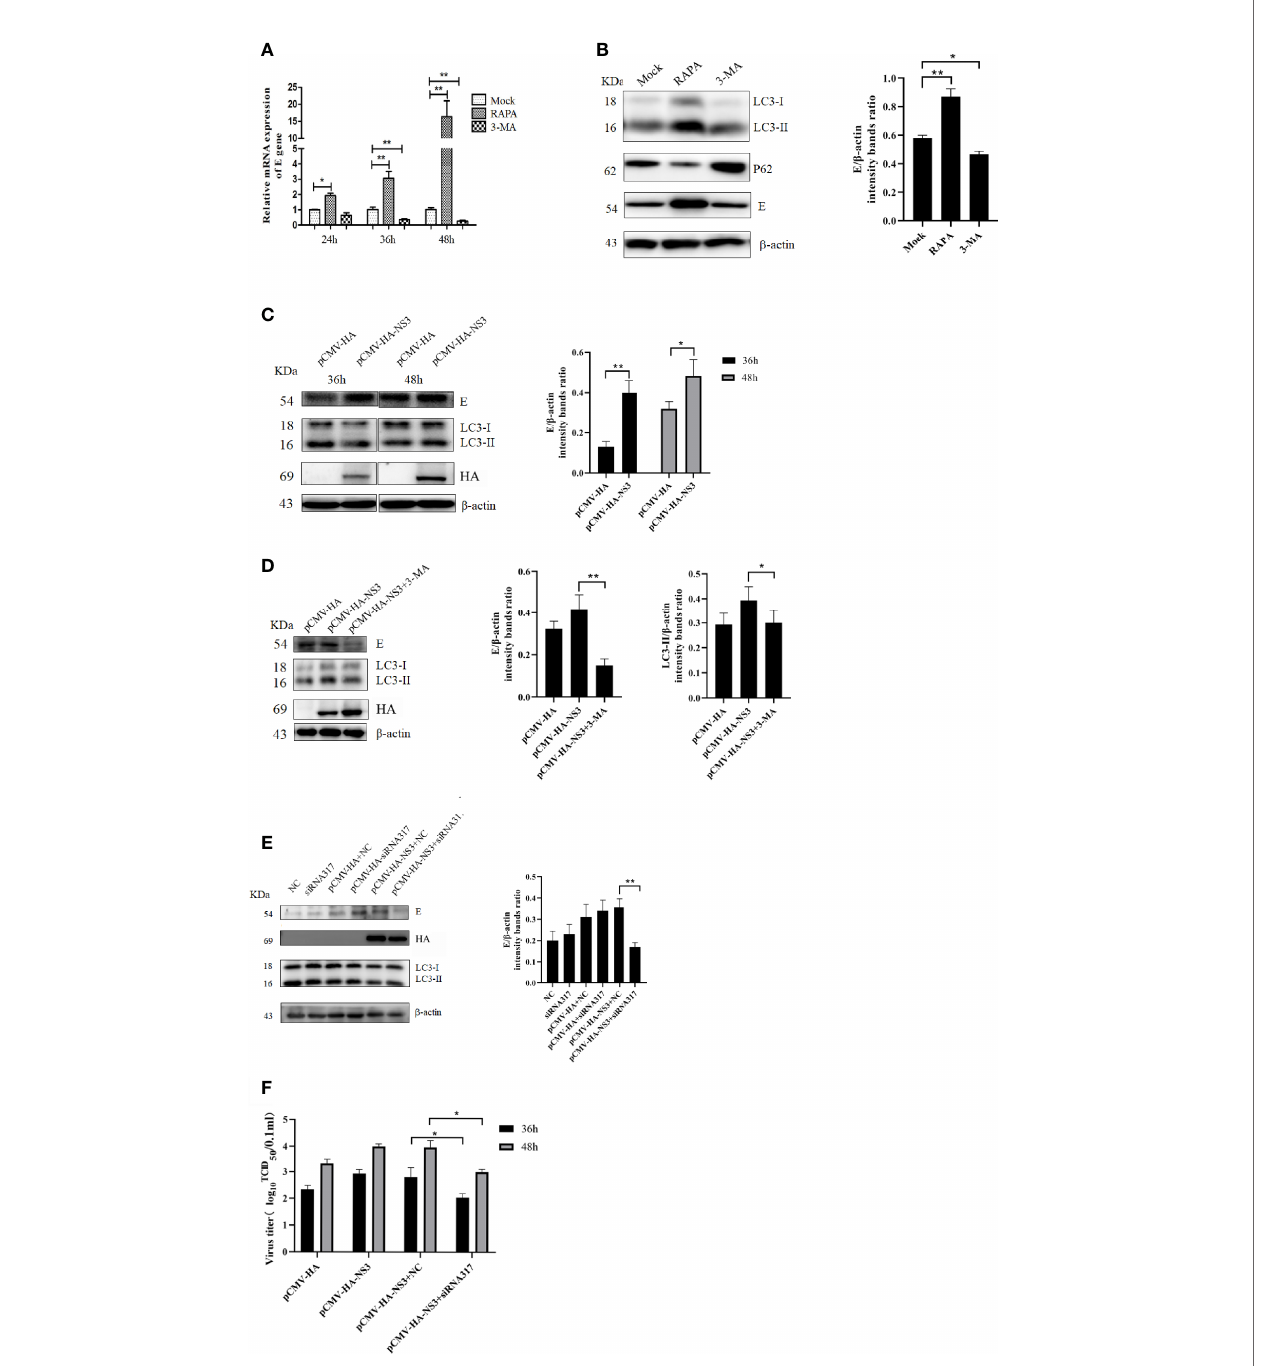
FIGURE 5 | Autophagy affects DTMUV ’ s replication. (A) DEF cells were treated with 3-MA (5 mM) or RAPA (5 m M) for 6 h to inhibit or induce autophagy, respectively, before being infected with DTMUV at an MOI of 0.3. Cell lysates were harvested at the indicated time for qPCR to test the relative expression of the E gene. (B) DEF cells infected with DTMUV for 36 h were lysed and analyzed by Western blot with anti-LC3, P62, and the E and b -actin antibodies. (C) BHK-21 cells were transfected with NS3 for 6 h and then infected with DTMUV (0.3 MOI), and the cell samples were collected at 36 and 48 hpi. (D) BHK-21 cells were treated with 3-MA (5 mM) for 6 h before being transfected with NS3 and subsequently infected with DTMUV. At 36 hpi, the E, LC3, and NS3 proteins were detected by Western blot. (E) DEF cells were transfected with NS3 for 6 h after being transfected siRNA for 24 h. The cells were infected with DTMUV (0.3 MOI), and the cell samples were collected at 36 hpi. (F) DEF cells were cultured in 6-well cell culture plates and infected with the virus (0.3 MOI) as described above. Cell supernatants were collected 36 and 48 h after infection, and virus titers were determined by the Reed – Muench two-step method. Data (M ± SD of technical triplicates) represent three independent experiments or are pooled from three independent experiments (M ± SD). * p < 0. 05; ** p < 0.